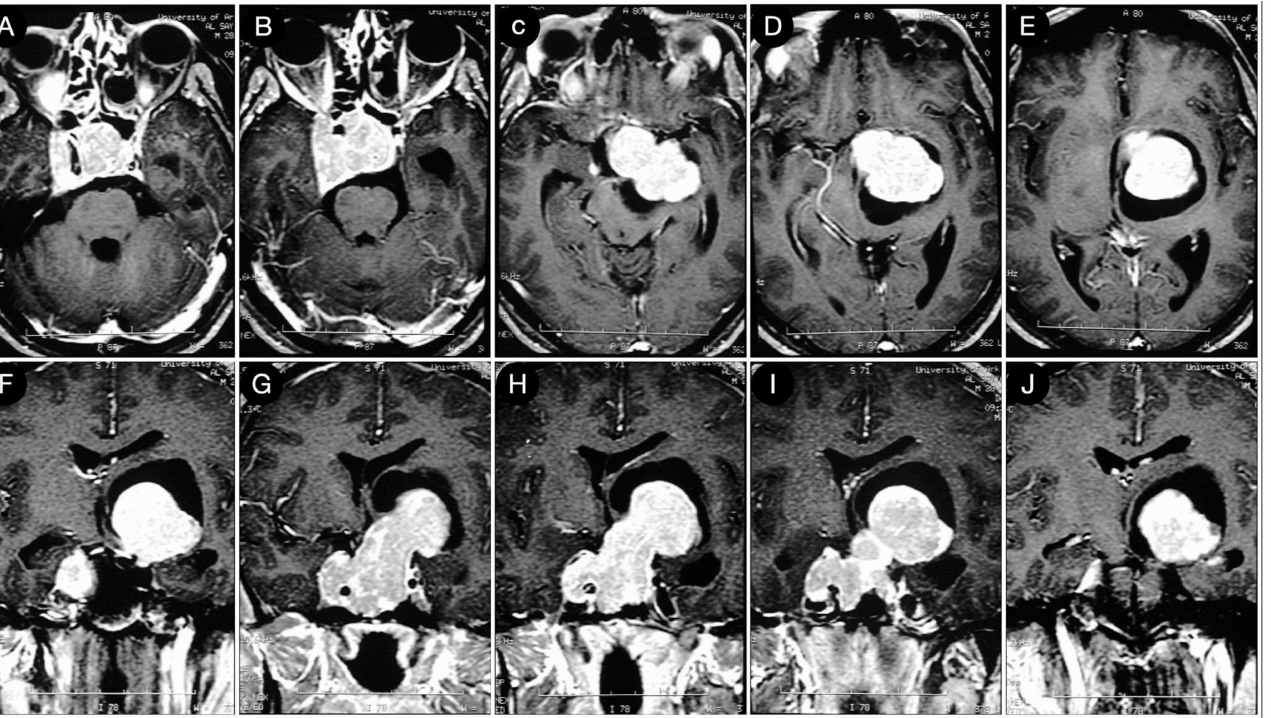
Figure 11. Preoperative axial ( A – E ) and coronal ( F – J ) T1-weighted contrast-enhanced MRI. Scale bar: 5